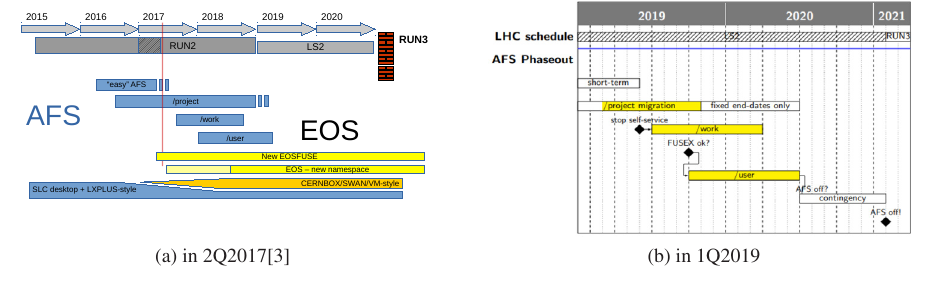
Figure 1: Evolution of the phaseout